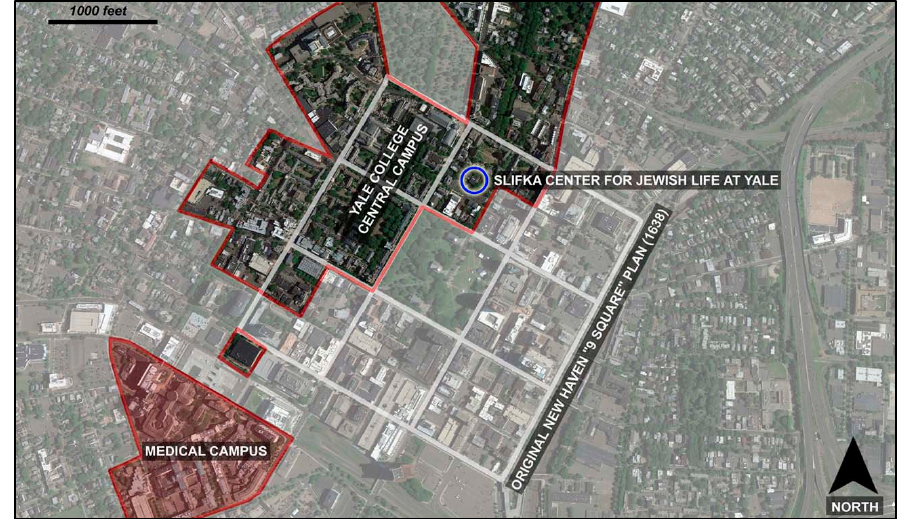
Figure 2. Slifka Center for Jewish Life at Yale, Location Plan. Image Credit: map data © 2018 Google, Landsat / Copernicus; reuse according to Google’s Terms of Service. Annotations by the